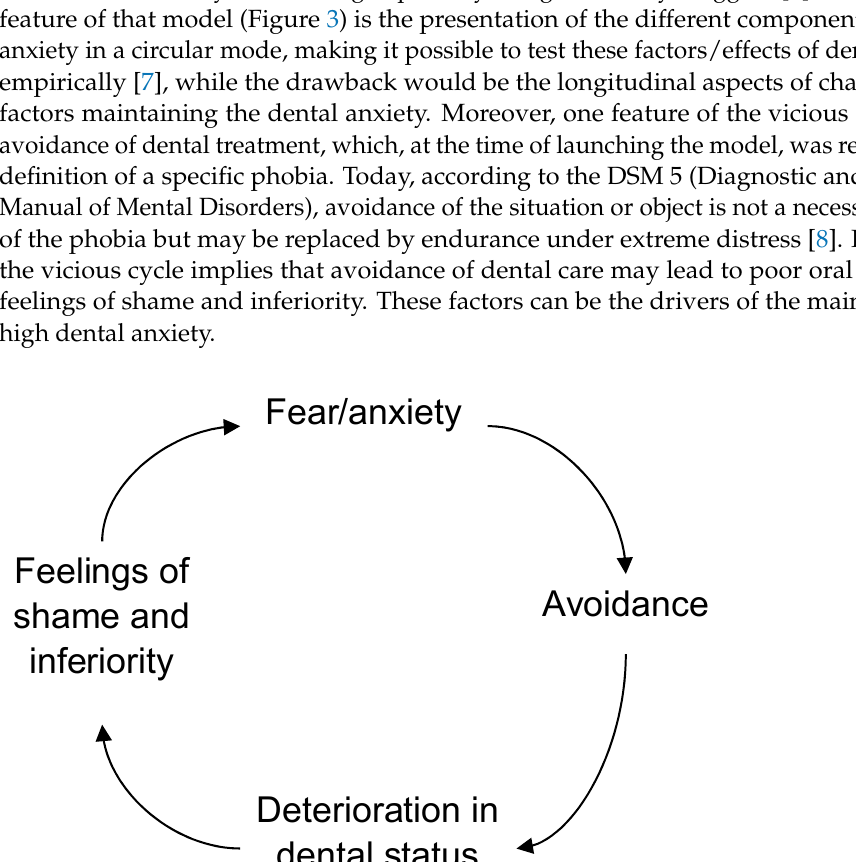
Figure 3. The vicious cycle of dental anxiety maintaining and enforcing dental anxiety [2].